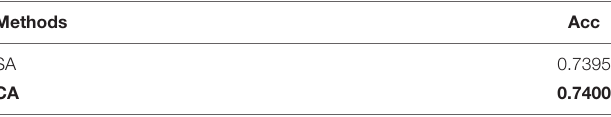
TABLE 4 | Results of ablation experiments with